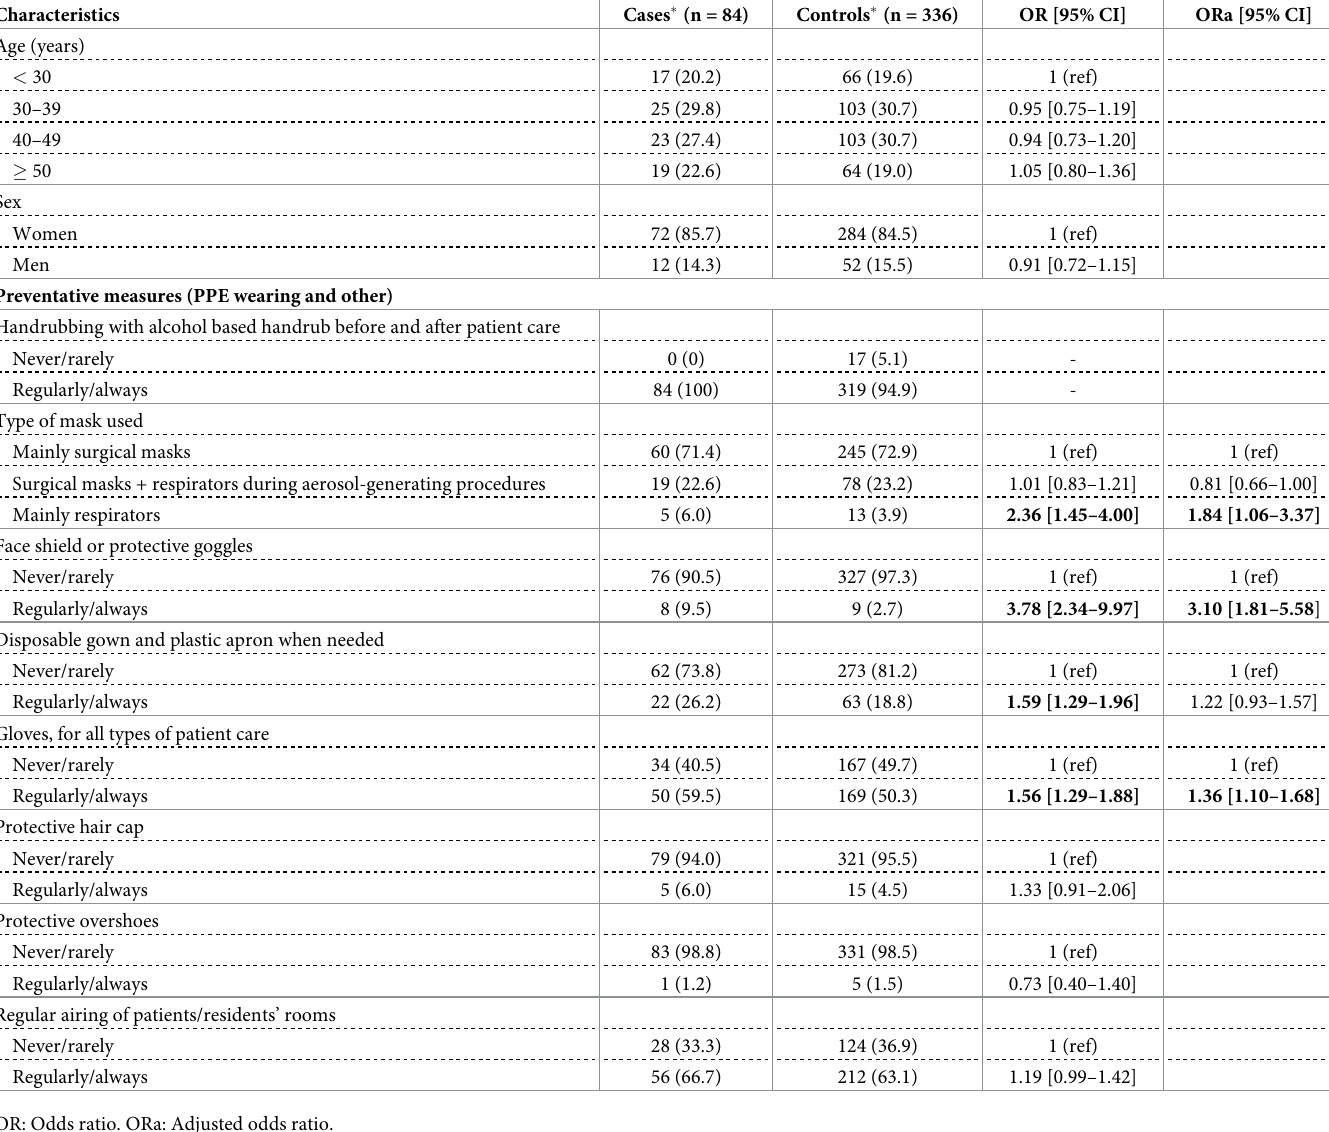
Table 3. Case-control study 2: Exposures associated with risk of COVID-19 among HCWs taking care of non COVID-19 positive patients.